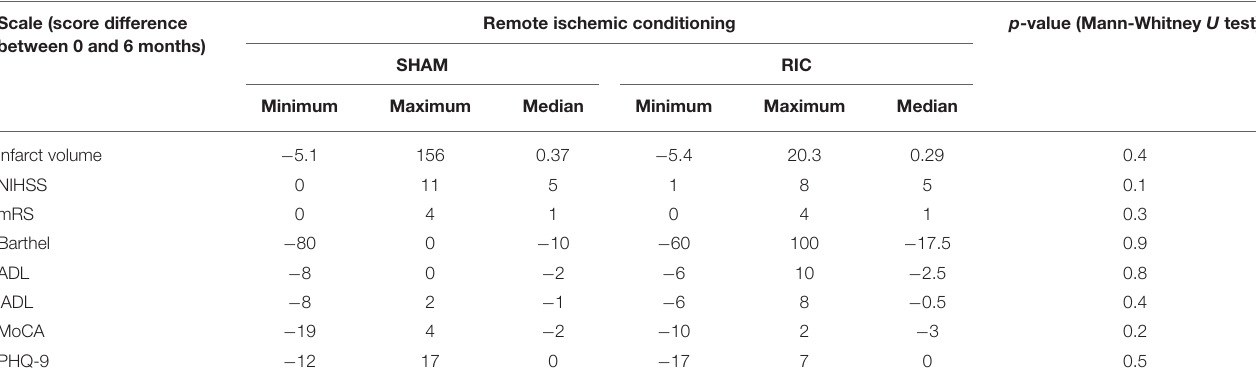
Remote ischemic